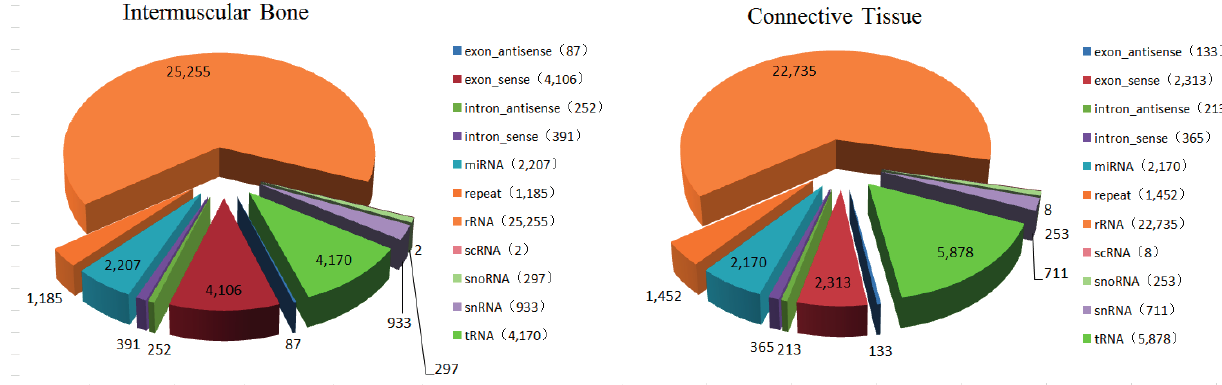
Figure 2. Annotation of small RNAs derived from the Intermuscular bones (IBs) and connective tissue (CT) of M. amblycephala